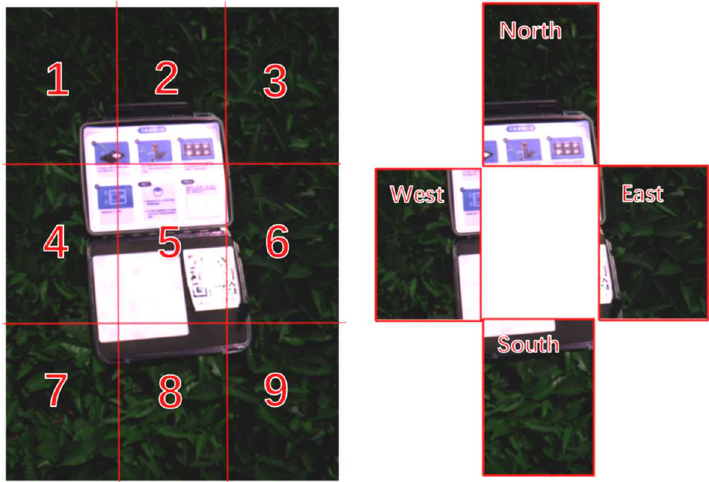
Figure 7. Canopy-scale image segmentation by orientation.